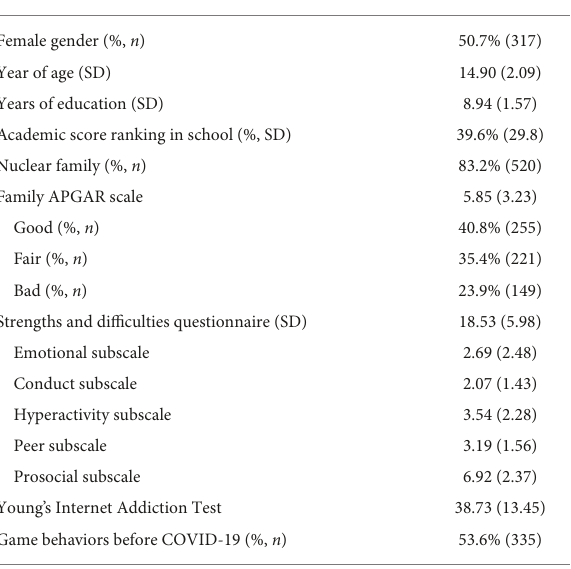
TABLE 1 The demographic and clinical characteristics of the